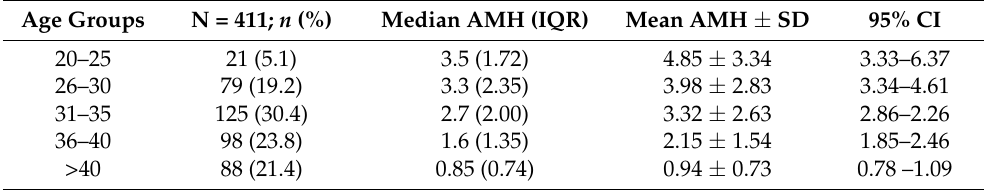
Table 1. Serum AMH levels in five age categories of women undergoing IVF treatment.